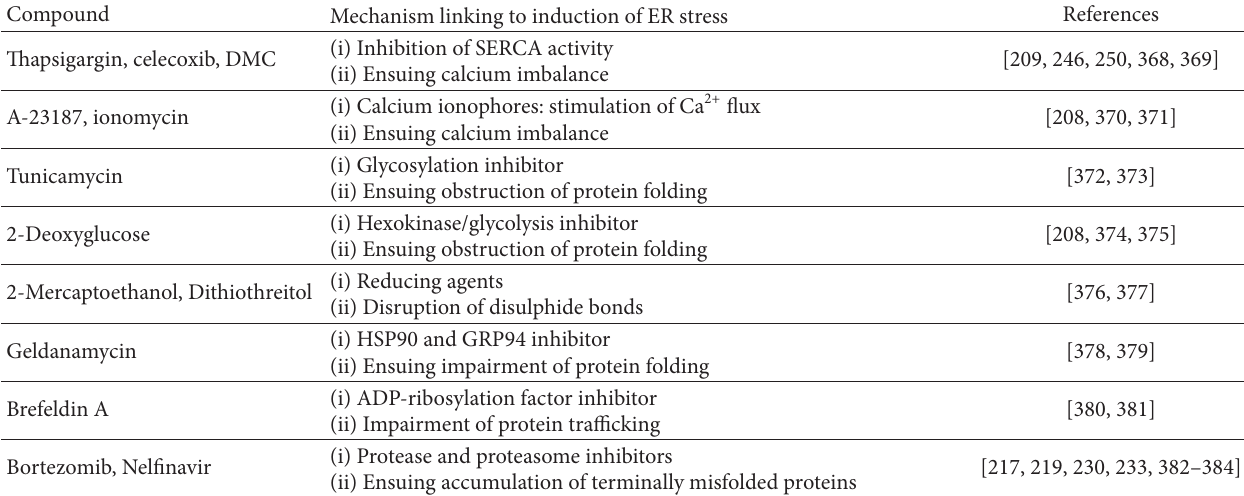
T 3: Representative compounds with potency to trigger and aggravate ER stress. Compound Mechanism linking to induction of ER